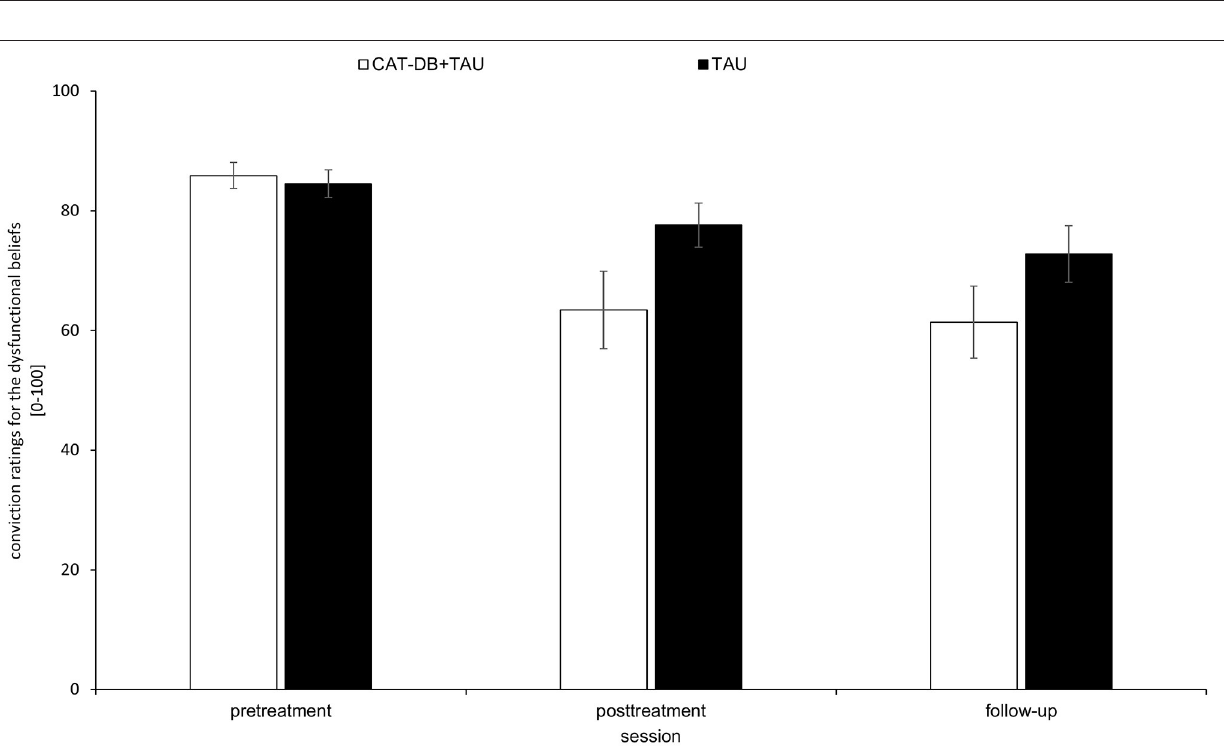
means of these differences differ significantly between the two groups. These t -tests were useful to analyse potential Group × Session interaction effects and further explore whether both groups evolve differently over the course of time. In our analyses we removed extreme values, as described below, that can be regarded as outliers. In Appendix B we report all analyses without removing any